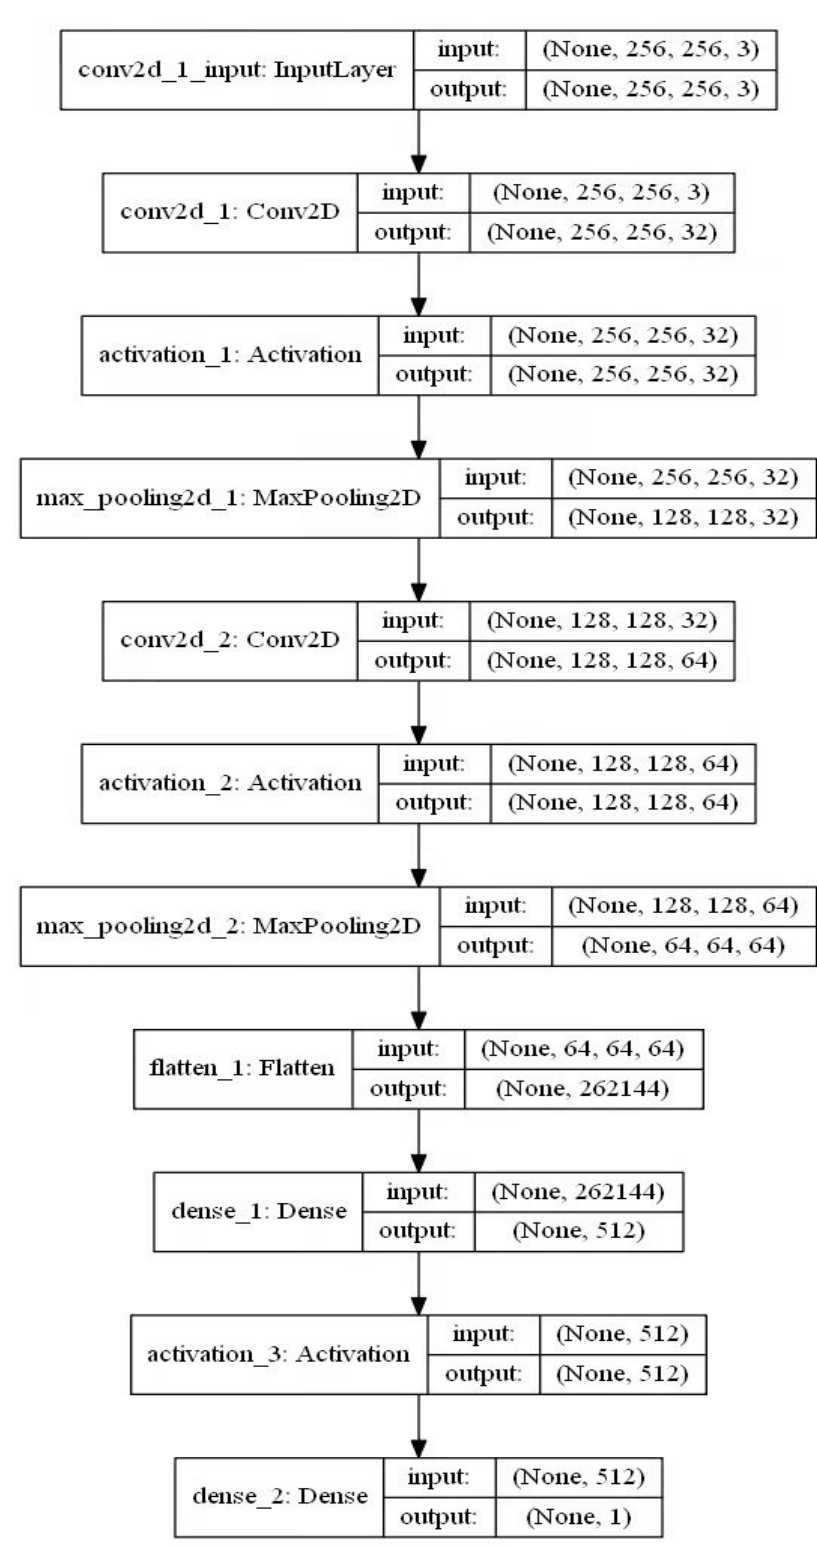
Figure 9. Schematic input and output volumes of each layer of convolutional neural network (CNN) model.